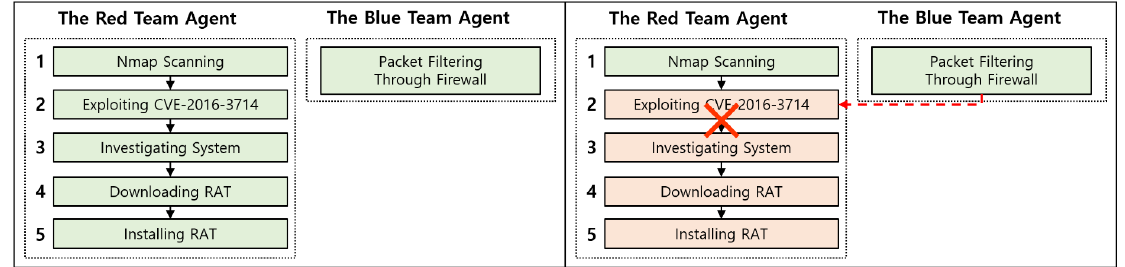
Figure 15. Available techniques for the red team agent and the blue team agent on the system with CVE-2016-3714 (left) and the red team agent’s failure of exploiting CVE-2016-3714 by the blue team agent’s mitigation